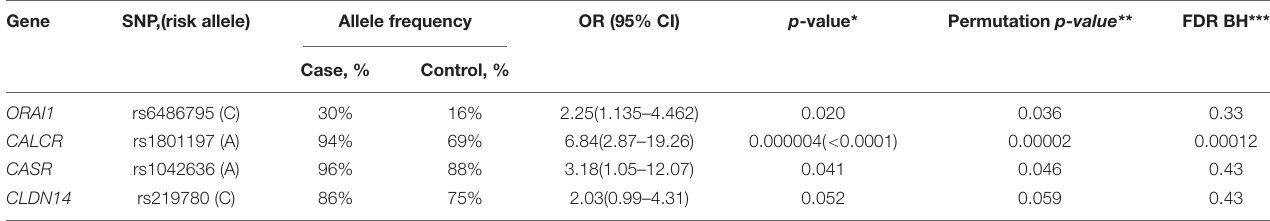
TABLE 1 | Associations between the risk of calcium urolithiasis development and polymorphisms of CASR, CALCR, ORAI1 , and CLDN14 genes. Gene